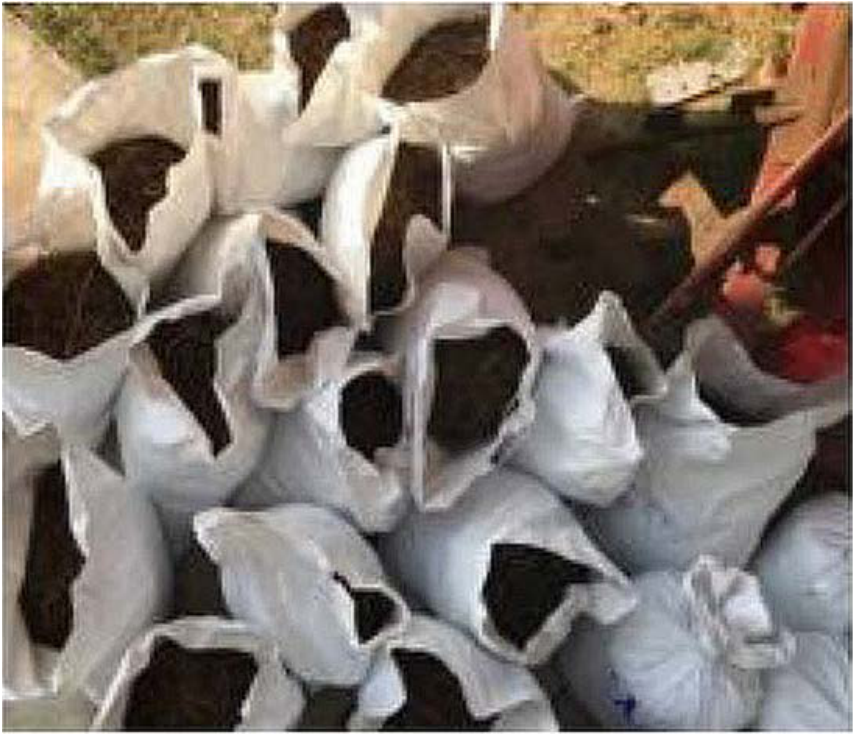
ship of moisture with time.